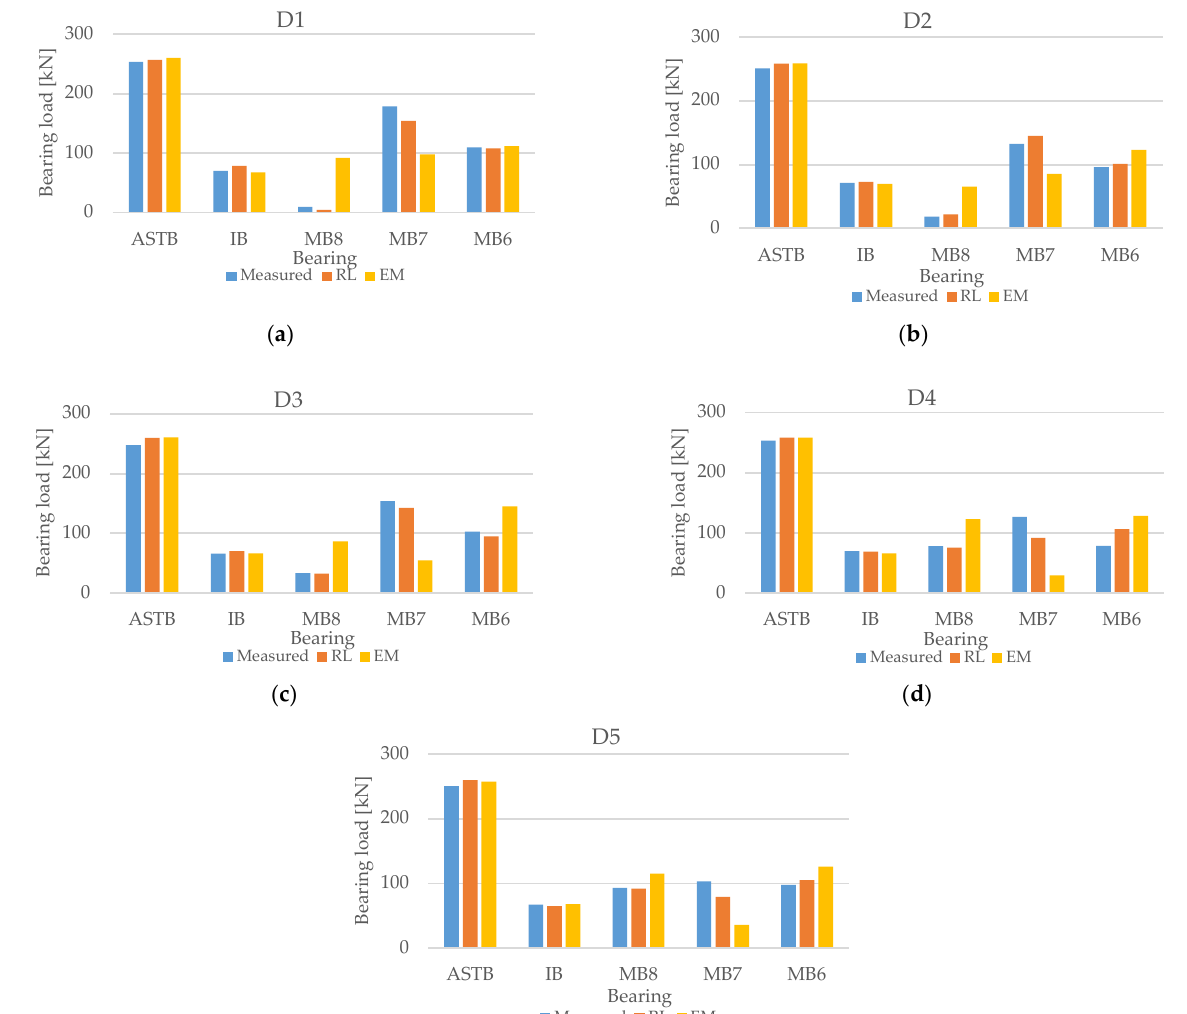
Figure 24. Comparison of reaction force prediction of ( a ) D1, ( b ) D2, ( c ) D3, ( d ) D4, and ( e ) D5.